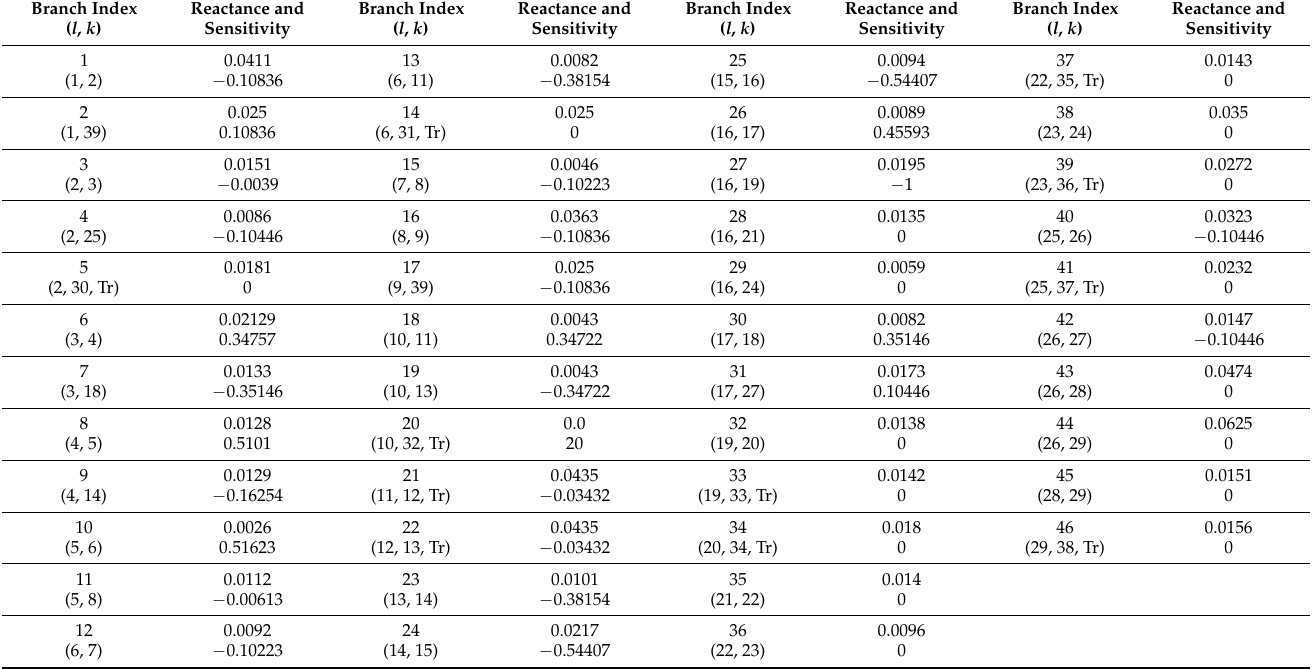
Table A1. Sensitivity Analysis